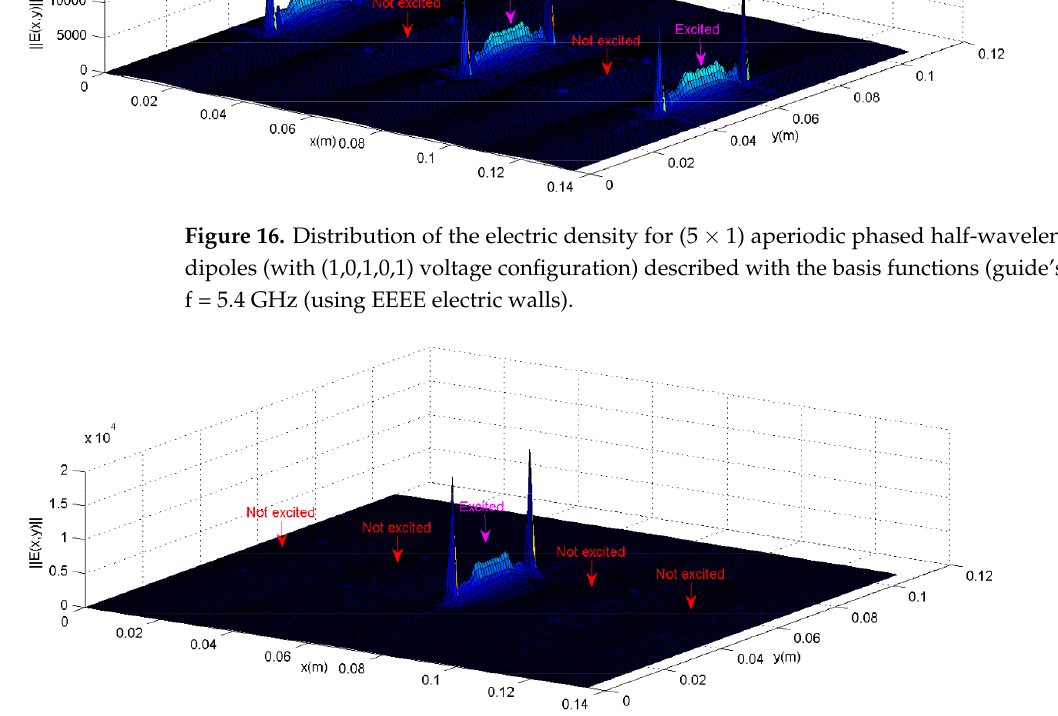
Figure 17. Distribution of the electric density for (5 × 1) aperiodic phased half-wavelength planar dipoles (with (0,0,1,0,0) voltage configuration) described with the basis functions (guide’s modes) at f = 5.4 GHz (using EEEE electric